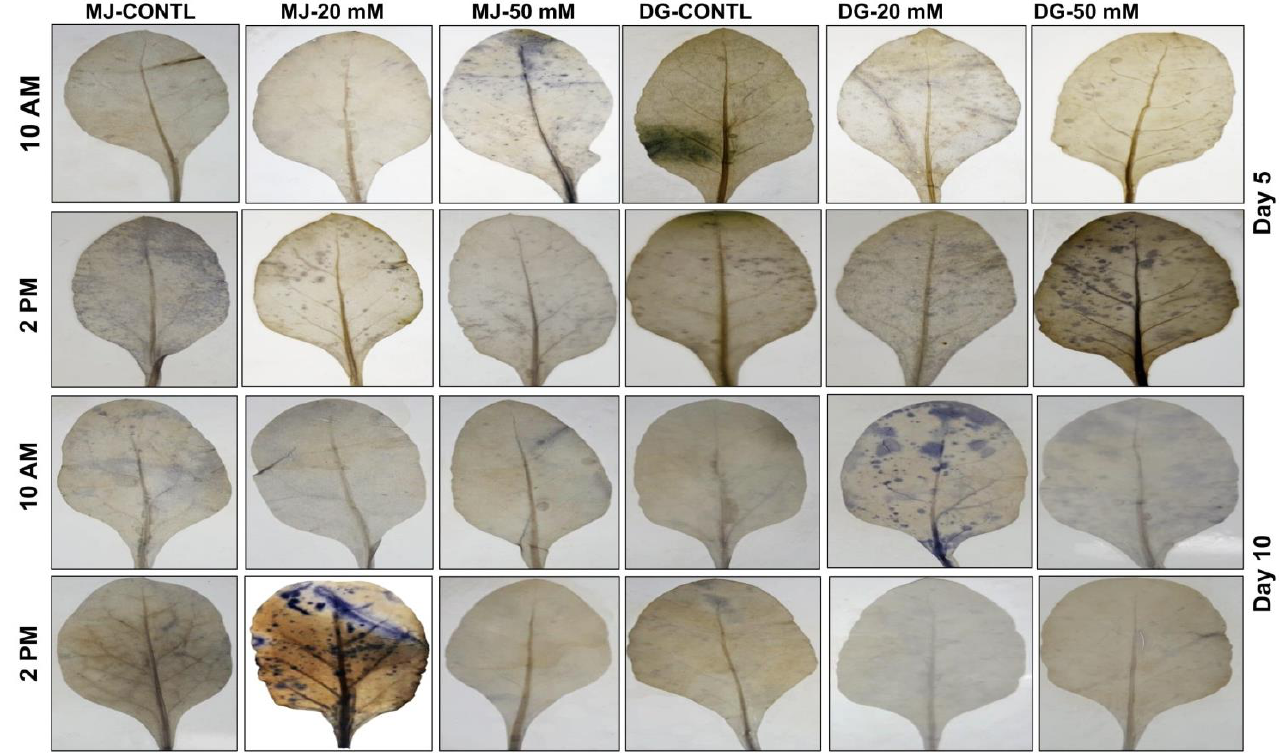
Figure 5. O 2 − 1 localizations in spinach genotypes Delhi green (DG) and Malav Jyoti (MJ). Images are presented for the controls (MJ control; DG control), 20 mM of NaCl treatments (MJ-20 mM; DG-20 mM), and 50 mM of NaCl treatments (MJ-50 mM; DG-50 mM). Sampling was performed (on the basis of the circadian cycle) at 4 h intervals corresponding to the times of 10 am and 2 pm on both day 5 and day 10 of salinity stress.